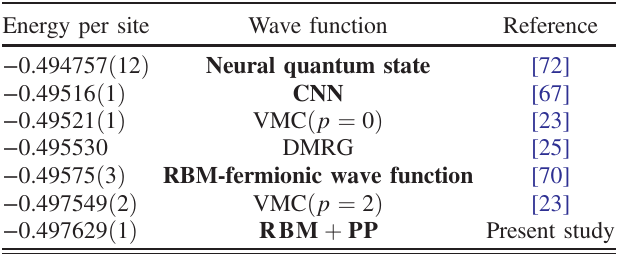
TABLE II. Comparison of ground-state energy for the 10 × 10 lattice at J 2 ¼ 0 . 5 among different wave functions. The wave functions in bold font use neural networks. In Ref. [23], p th order Lanczos steps are applied to the VMC wave function. CNN stands for convolutional neural